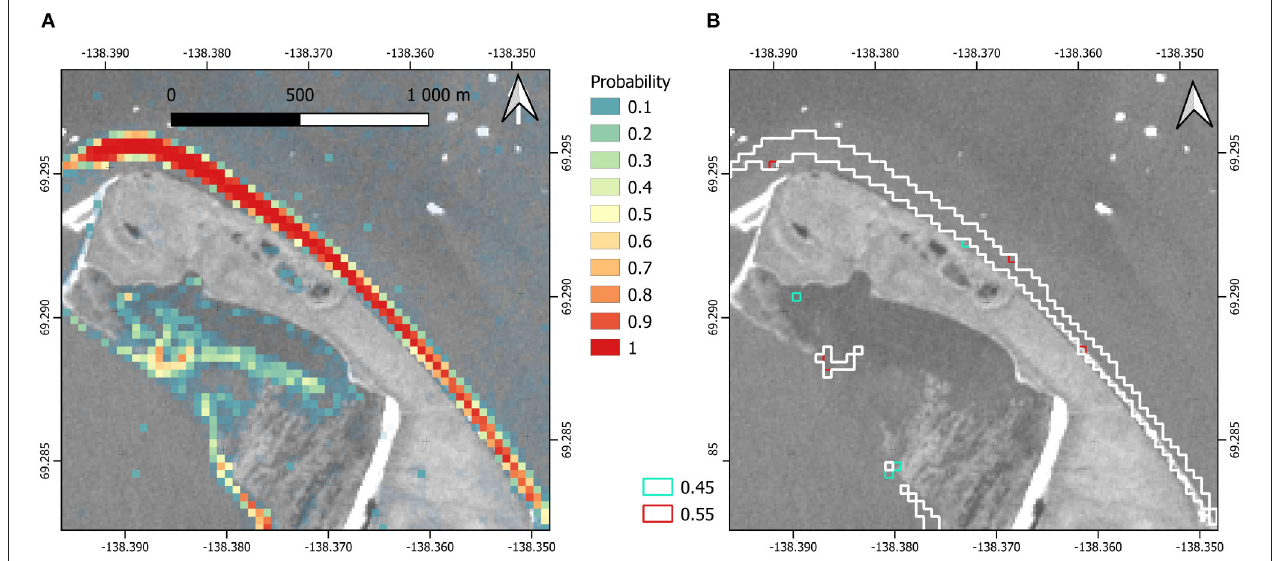
Frontiers in Environmental Science |